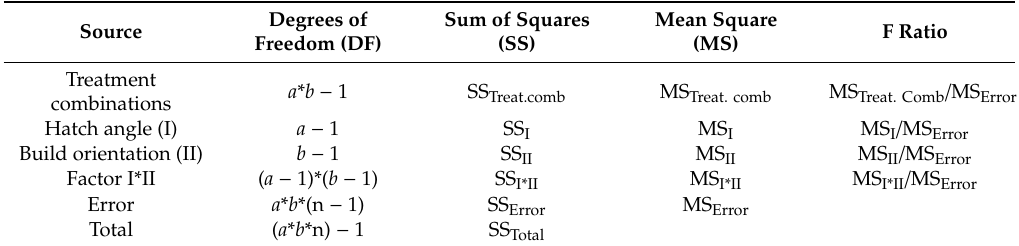
Table 5. ANOVA table for the factorial experiment.